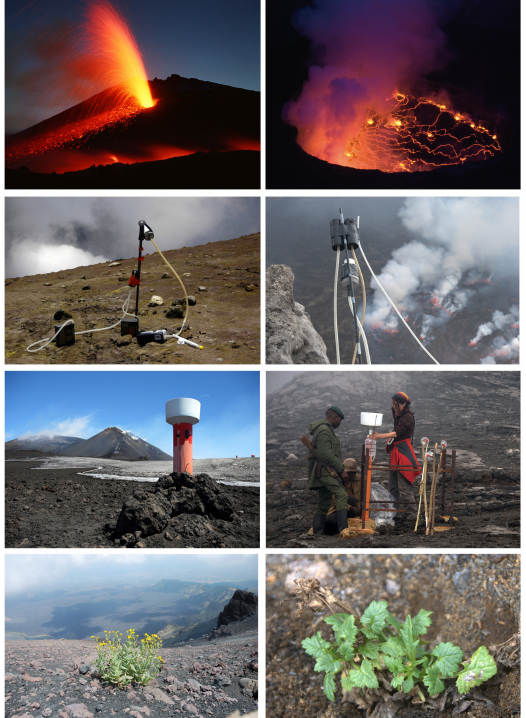
Figure 1: Sampling at Mt. Etna (on the left) and Nyiragongo (on the right). From the top: volcanic activ- ity; plume sampling; the bulk collectors; vegetation for